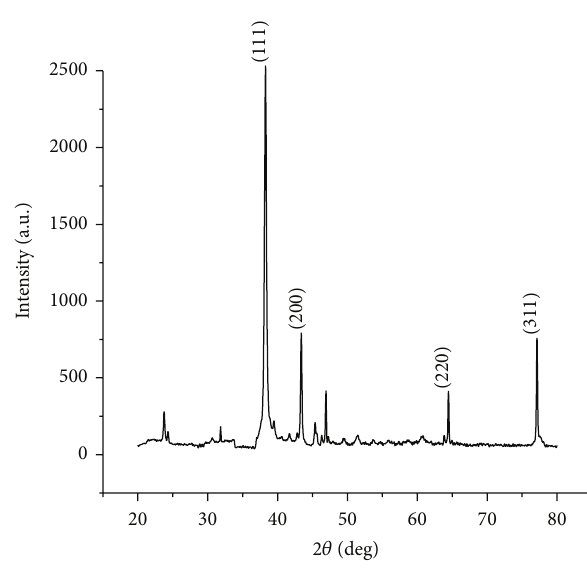
Figure 2: X-ray diffraction pattern of synthesized